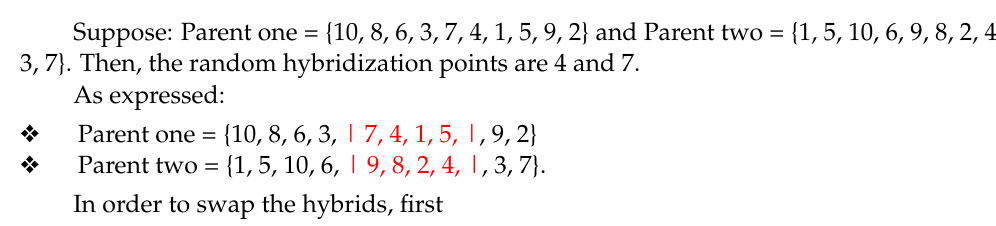
Figure 7. The first step of the reconfiguration algorithm (before